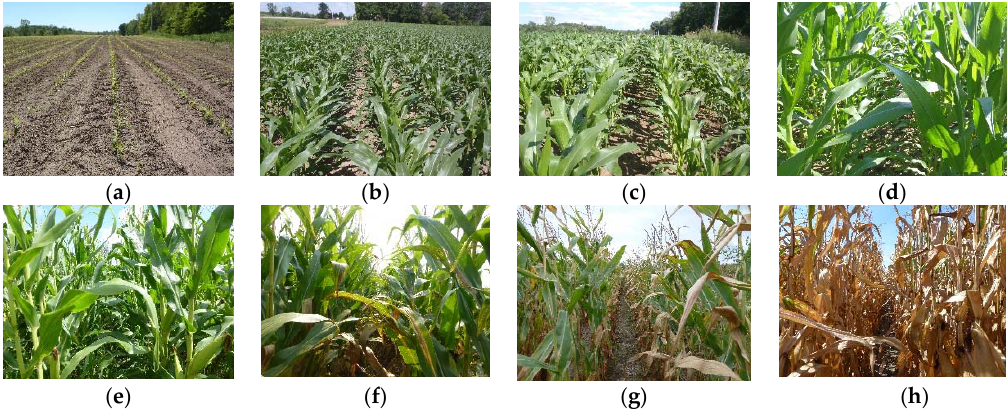
Figure 9. The ground truth photos of corn. ( a ) May 23, ( b ) June 19, ( c ) July 2, ( d ) July 16, ( e ) August 11, ( f ) September 3, ( g ) September 13 and ( h ) September 25.